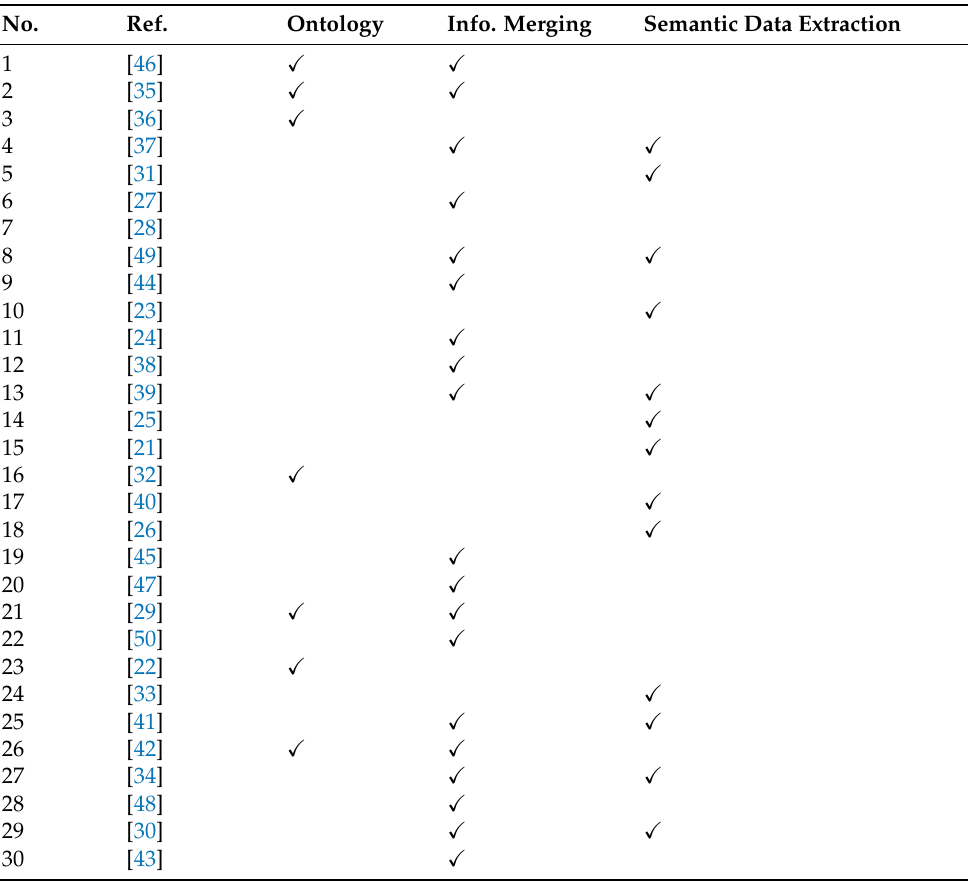
Table 9. Identified method for visual semantic